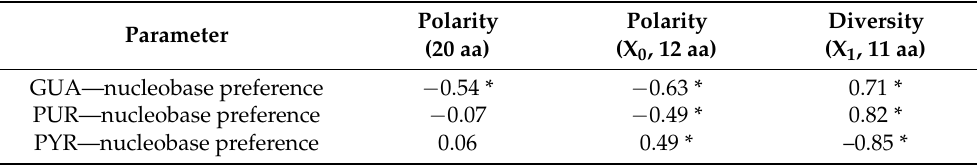
Table 3. Correlations between amino acid factors and preference scales in frames 0 and +1 ( − 2).